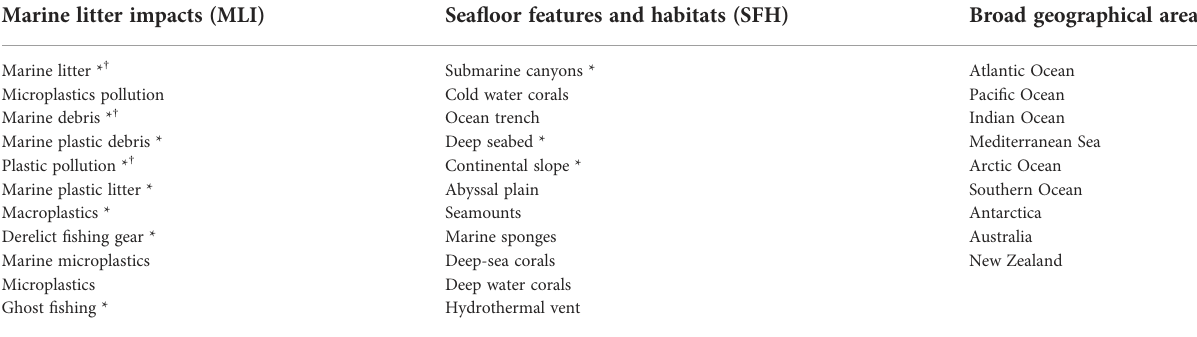
TABLE 1 List of marine litter impacts, sea fl oor features and habitats and broad geographical areas used to conduct searches. Marine litter impacts